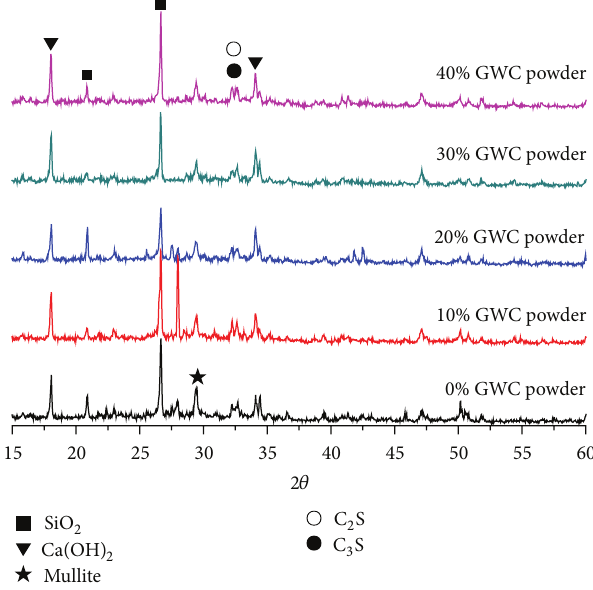
Figure 5: XRD pattern of hardened